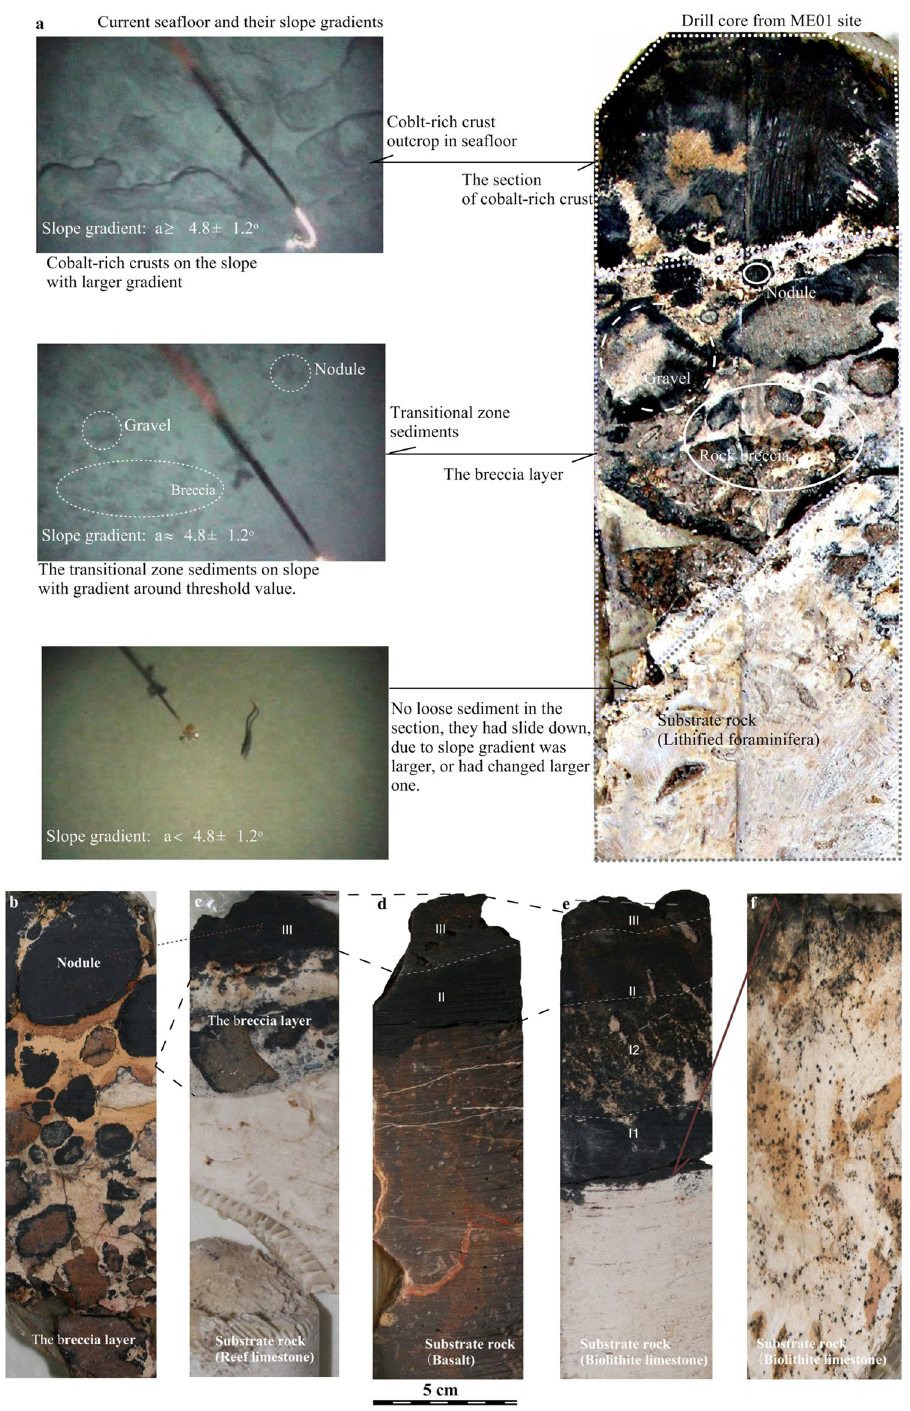
Figure 4. ( a ) The left panel shows seafloor images from the TV video survey line shown in Fig. 2a. The right panel is a sample section from a drill core at site ME01 (Fig. 2a), with cobalt-rich crust, a breccia layer and substrate rock appearing from top to bottom. The cobalt-rich crust and breccia layer are approximately 25 and 50 mm thick, respectively. The top two layers in the section appear to be accumulated by transitional zone sediments and cobalt-rich crust, which are shown in left images. Other sections of shallow drill cores are shown in ( b – f ) and will be discussed in the following